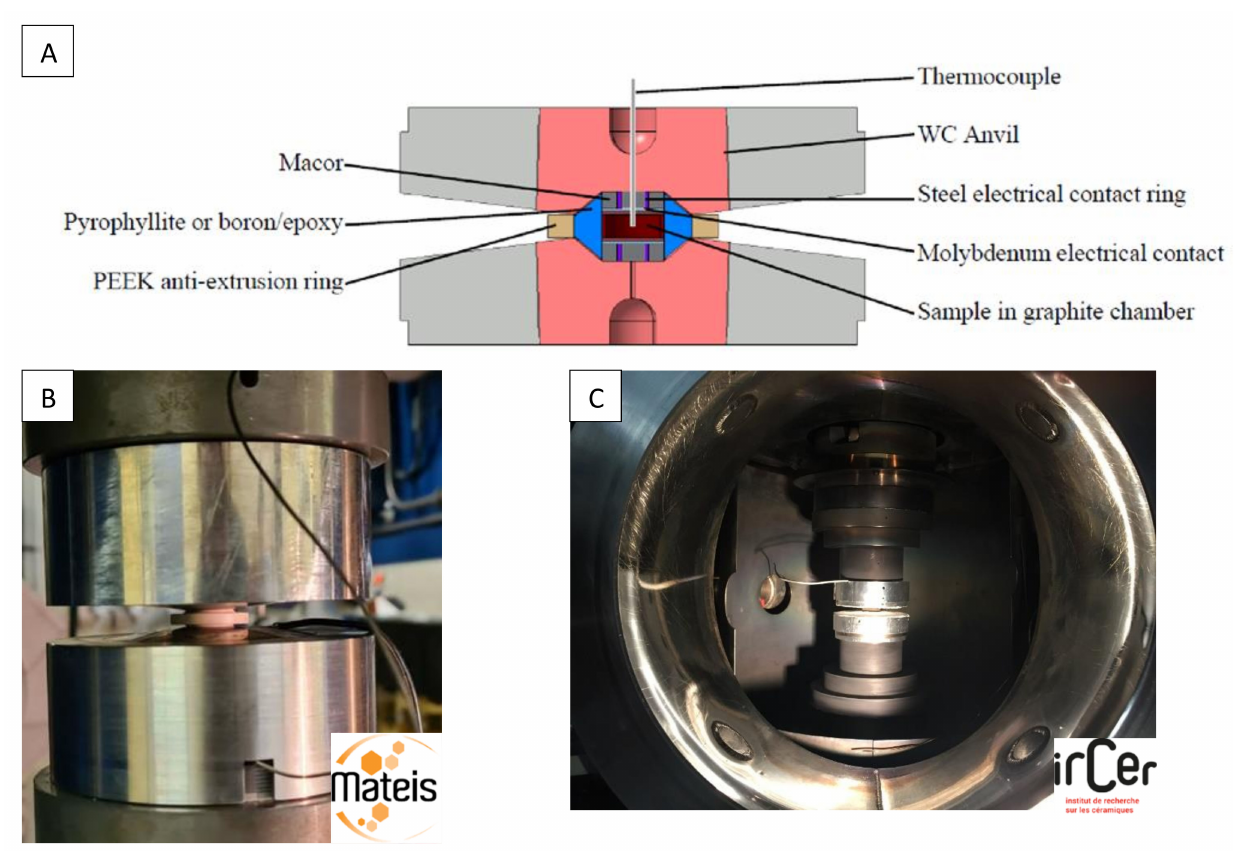
Figure 5. ( A ) Section view of the sample cell assembly between two WC anvils ( B ) The Paris– Edinburgh HP-SPS module mounted in the SPS-HPD 25 (FCT) chamber and ( C ) in the Dr. Sinter SPS 825 chamber, working up to 2 GPa. Experiments were performed in two different laboratories: MATEIS, Lyon (France) and IRCER, Limoges (France).